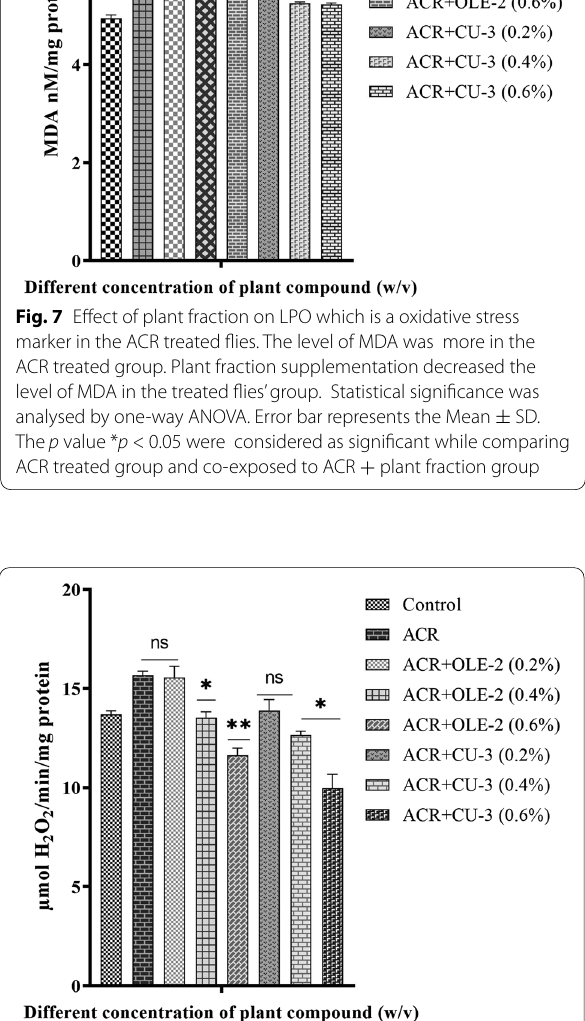
Fig. 8 Effect of plant fraction on catalase, an oxidative stress marker in the ACR treated flies. The level of catalase wasmore in ACR treated group. Plant fraction supplementation decreased the level of catalase in the treated flies group.Statistical significance was by one-way ANOVA. Error bar represents the Mean SD. The p values * p < 0.05 ± and ** p < 0.01were considered as significant while comparing ACR treated group and co-exposed to ACR plant fraction group +